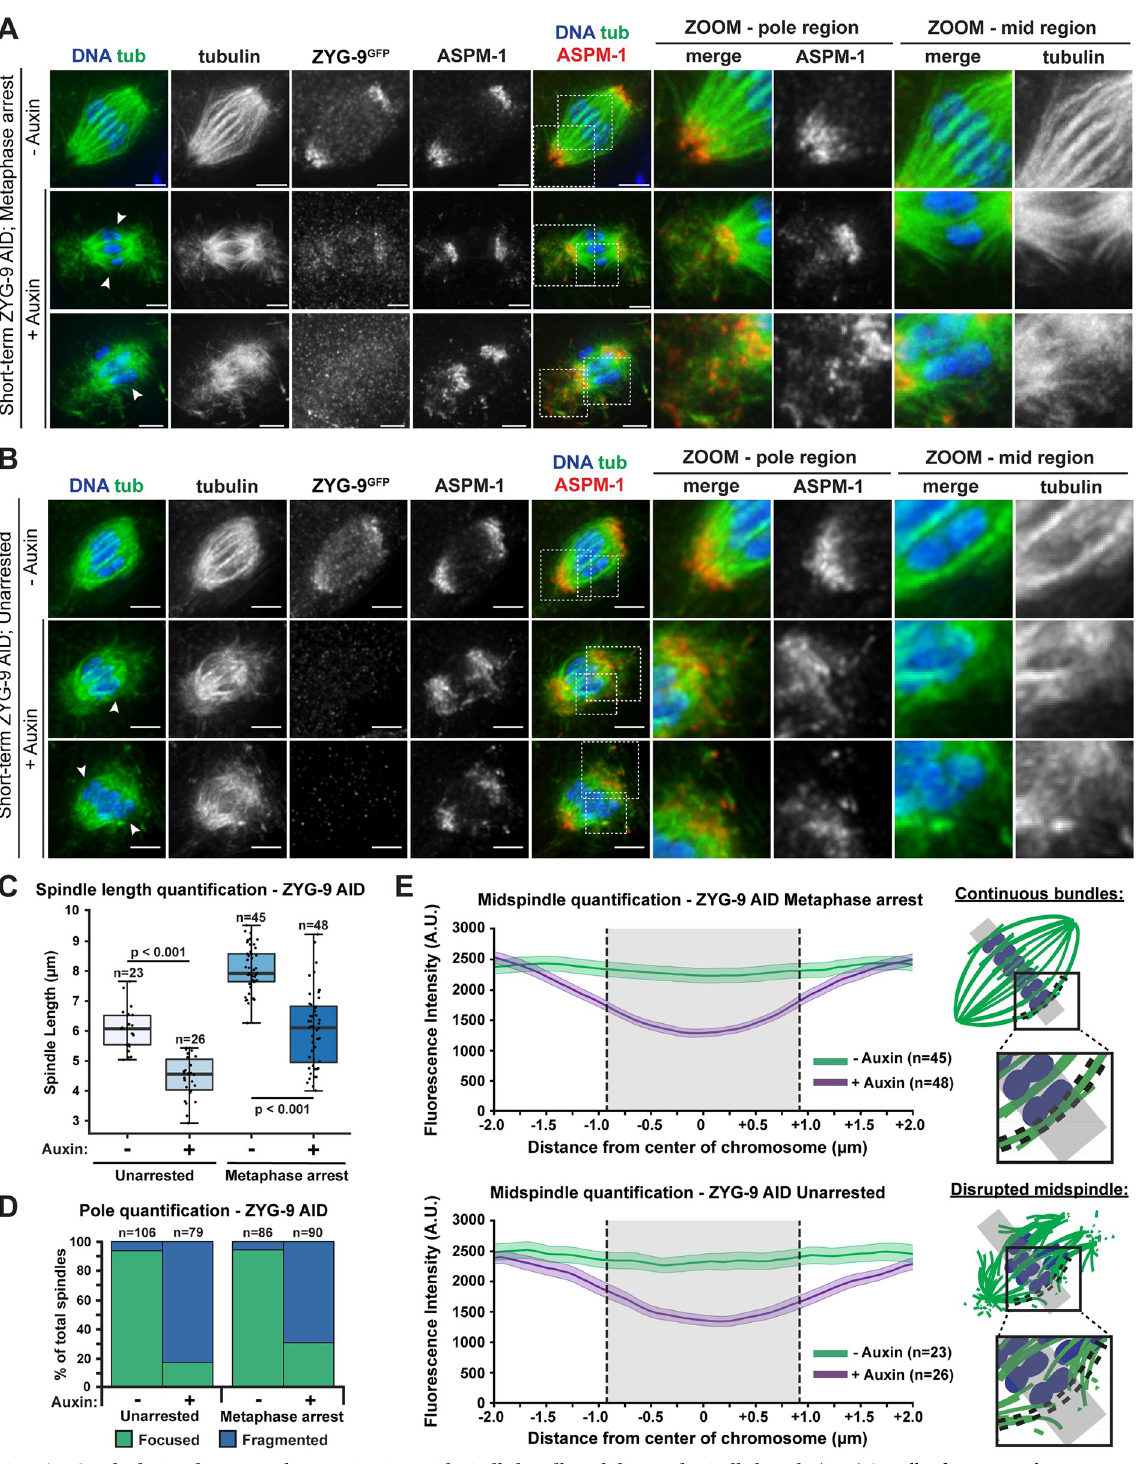
Fig 3. ZYG-9 depletion disrupts pole organization, midspindle bundle stability, and spindle length. (A, B) Spindles from Metaphase I- arrested (emb-30(RNAi)) oocytes (A) or unarrested oocytes (B) treated with vehicle or 1mM auxin for 25–30 minutes. Shown are DNA (blue), tubulin (green), ASPM-1 (red), and ZYG-9 (stained with a GFP antibody; not shown in merge). In vehicle-treated oocyte spindles, the poles are tightly organized, and the microtubule bundles appear to cross from one side of the spindle to the other without interruption. In spindles from auxin-treated oocytes, the ZYG-9 signal is decreased and spindle pole integrity is compromised as shown by ASPM-1 and tubulin coming off